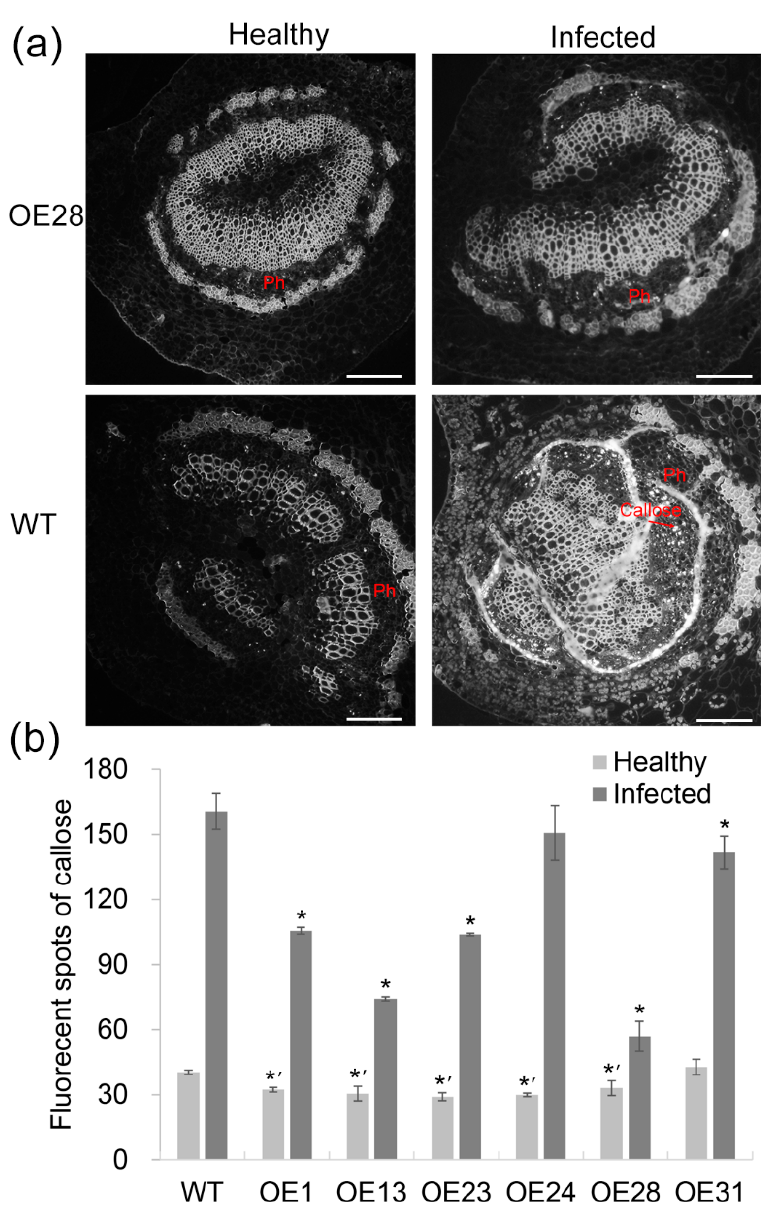
Figure 5. Comparison of callose deposition in the phloem of the transgenic and WT plants. ( a ) Anatomical analysis of callose in the midrib phloem tissues 24 months after Candidatus Liberibac- ter asiaticus (Las) infection. The slides were stained with 0.05% aniline blue solution and observed using a fluorescent microscope with a UV filter. Light spots represent callose deposits in the phloem. ( b ) Callose quantification in the leaf midribs 24 months after Las infection. Callose was quantified by the number of fluorescent spots in the phloem from each sample. Ten slides were counted per sample for each test. The vertical bars indicate the standard deviations of the means of three tests. * and *’ represent statistically significant differences from healthy and Las-infected WT controls, respectively, based on a Tukey’s test ( p < 0.05). WT, wild type; OE#, transgenic plants. Ph, phloem. In ( a ), bar = 100 µm.